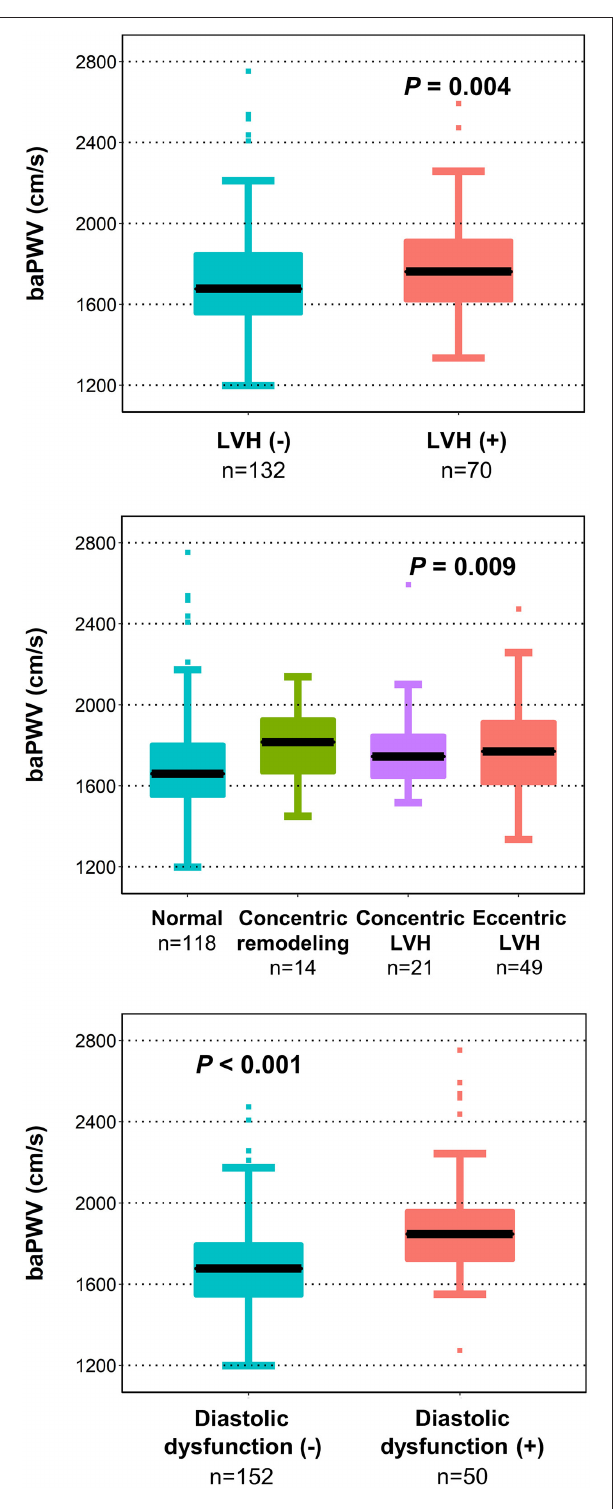
FIGURE 2 | Association of LV remodeling patterns and diastolic dysfunction with baPWV. The baPWV value by LV remodeling patterns and diastolic dysfunction is shown as a boxplot with the median (black line) and interquartile range. baPWV, brachial-ankle pulse wave velocity; LV, left ventricular; LVH, left ventricular